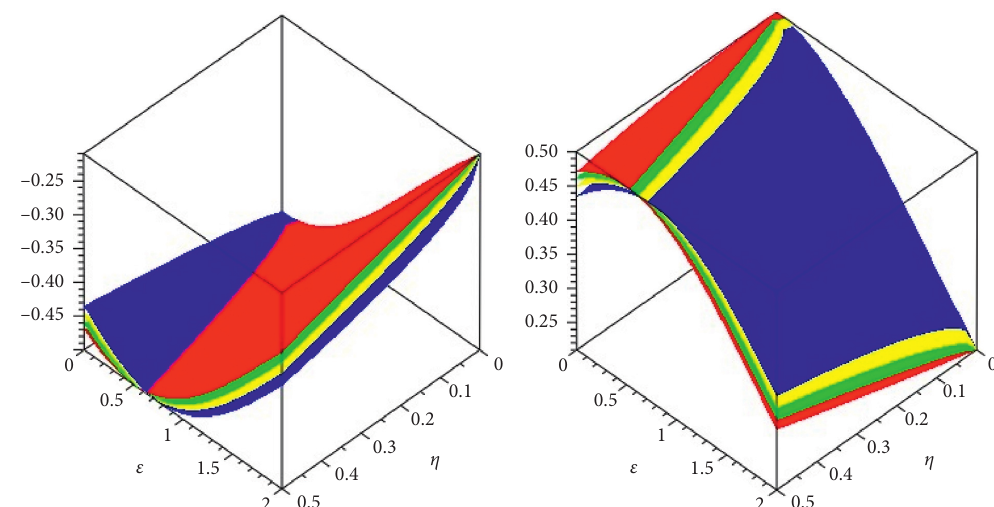
Figure 4: Various factional orders of the upper and lower fuzzy figure of analytical solution of example